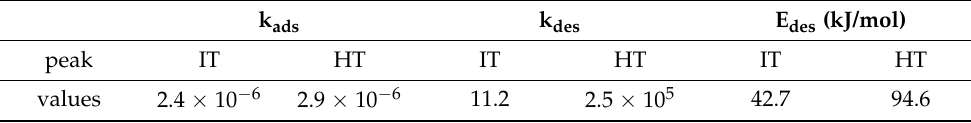
Table 2. The values of k ads , k des , and E des of the HT and IT